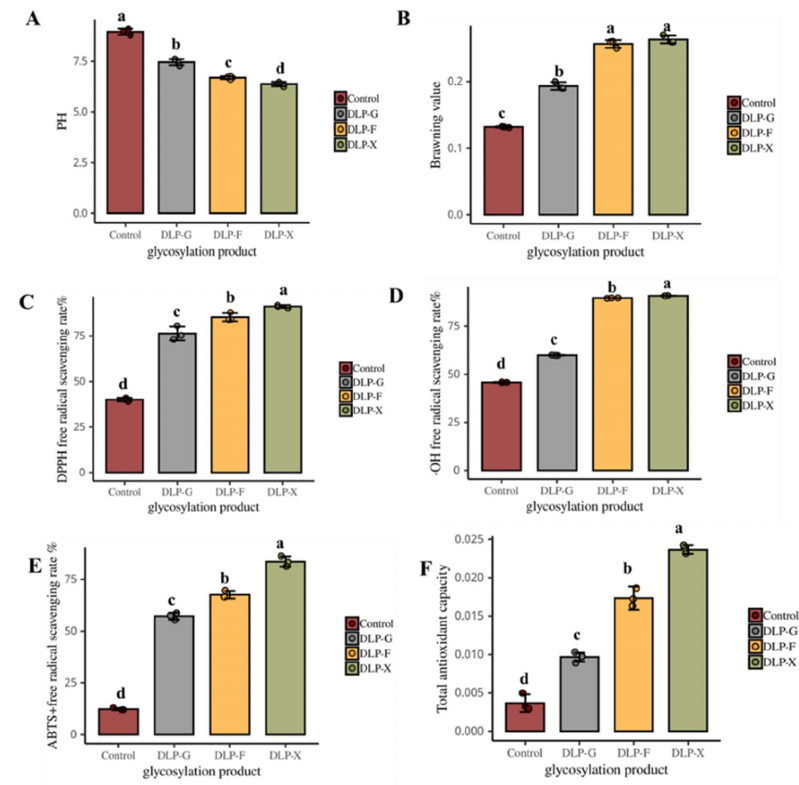
Figure 1. Effect of different reducing sugars on the in vitro antioxidant properties of duck liver protein glycosylation products they should be listed as: ( A ) shows the effect of different reducing sugars on the pH of the duck liver protein glycosylation products; ( B ) shows the effect of different reducing sugars on the degree of browning of the duck liver protein glycosylation products; ( C ) represents the effect of different reducing sugars on the scavenging of DPPH radicals by duck liver protein glycosylation products; ( D ) represents the effect of different reducing sugars on the scavenging of -OH radicals by duck liver protein glycosylation products; ( E ) represents the effect of different reducing sugars on the scavenging of ABTS + radicals by duck liver protein glycosylation products; ( F ) represents the effect of different reducing sugars on the total antioxidant capacity of duck liver protein glycosylation products. (Note: Different letters indicate that the samples are significantly different at α = 0.05 level. The duck liver protein glycosylated products by glucose, fructose, and xylose were named as DLP-G, DLP-F, and DLP-X,